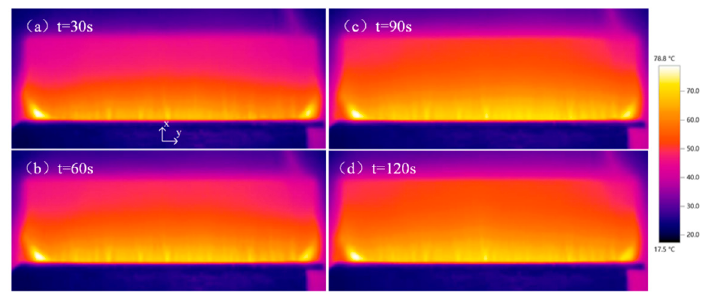
Figure 11. Comparison of the temperature distribution at different times.